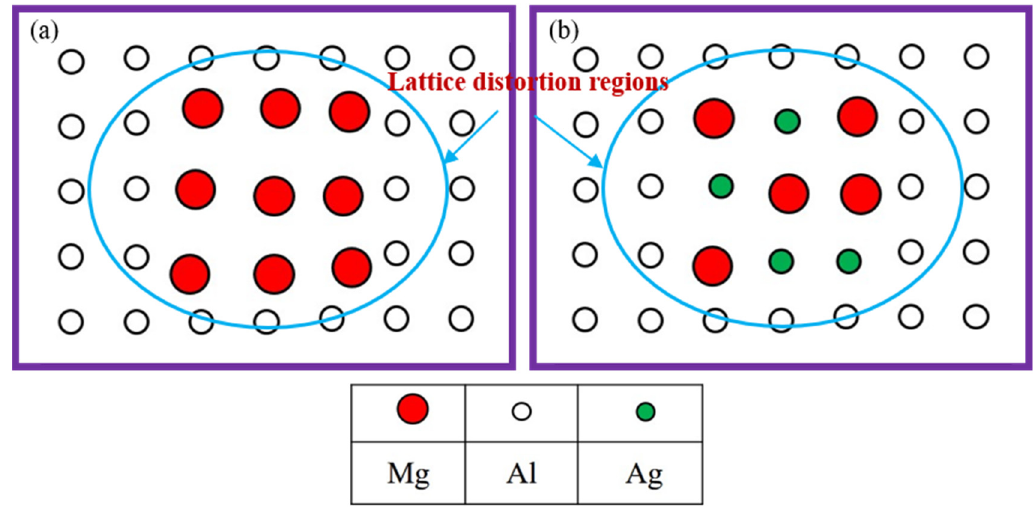
Figure 6. Diagram of the atomic aggregation of the alloys without ( a ) and with ( b ) Ag